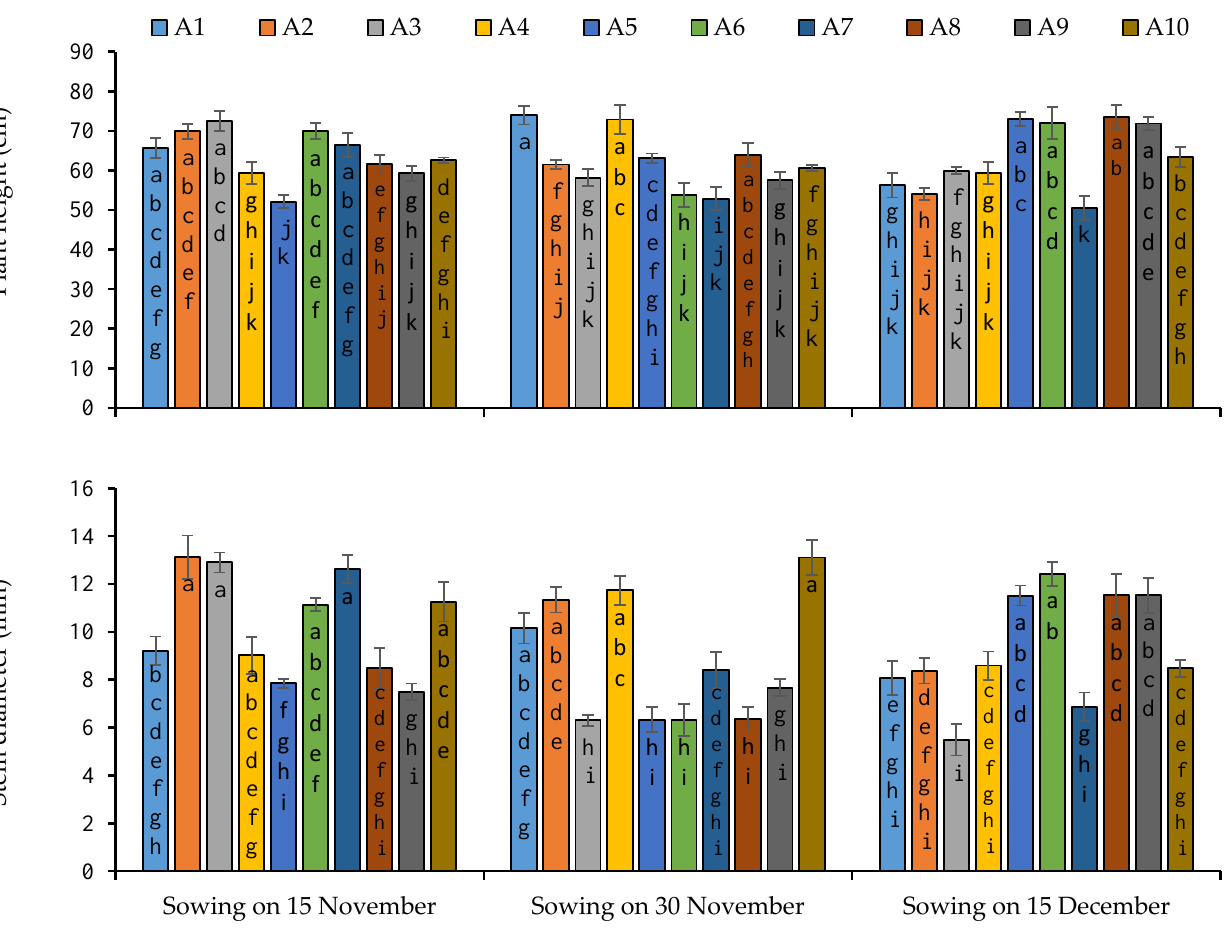
Figure 3. Plant height and stem diameter of quinoa lines grown under varying sowing dates. Bars sharing the same alphabet did not differ significantly at p < 0.05. Small alphabets (a, b, c. etc.) are used to express the statistical significant difference.